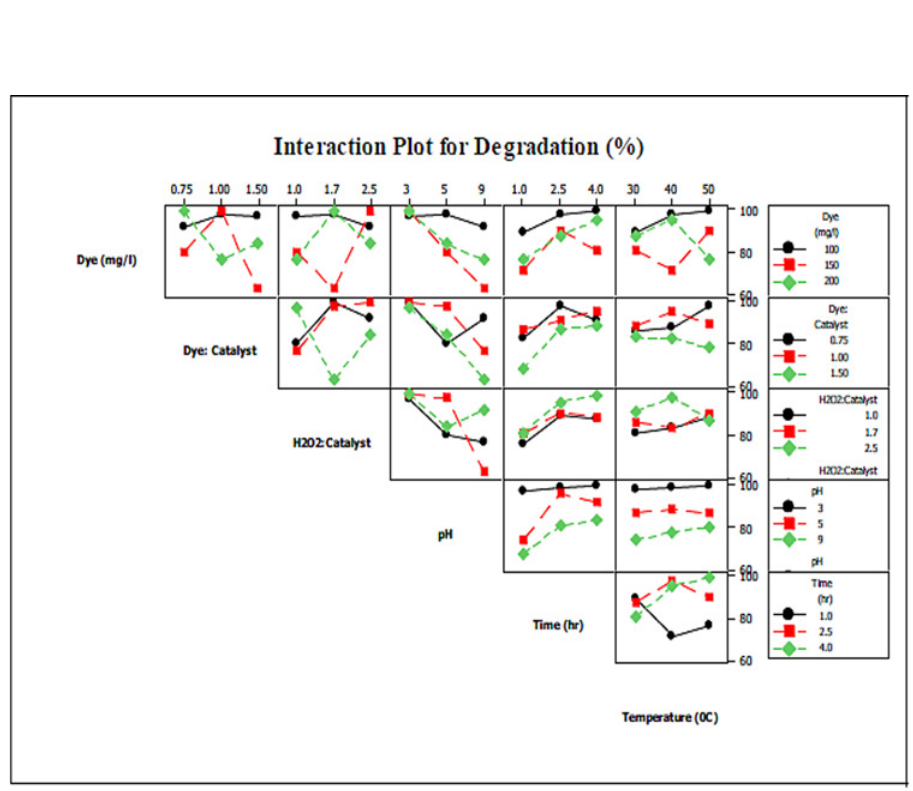
Fig 7. Interaction of parameters with respect to degradation.